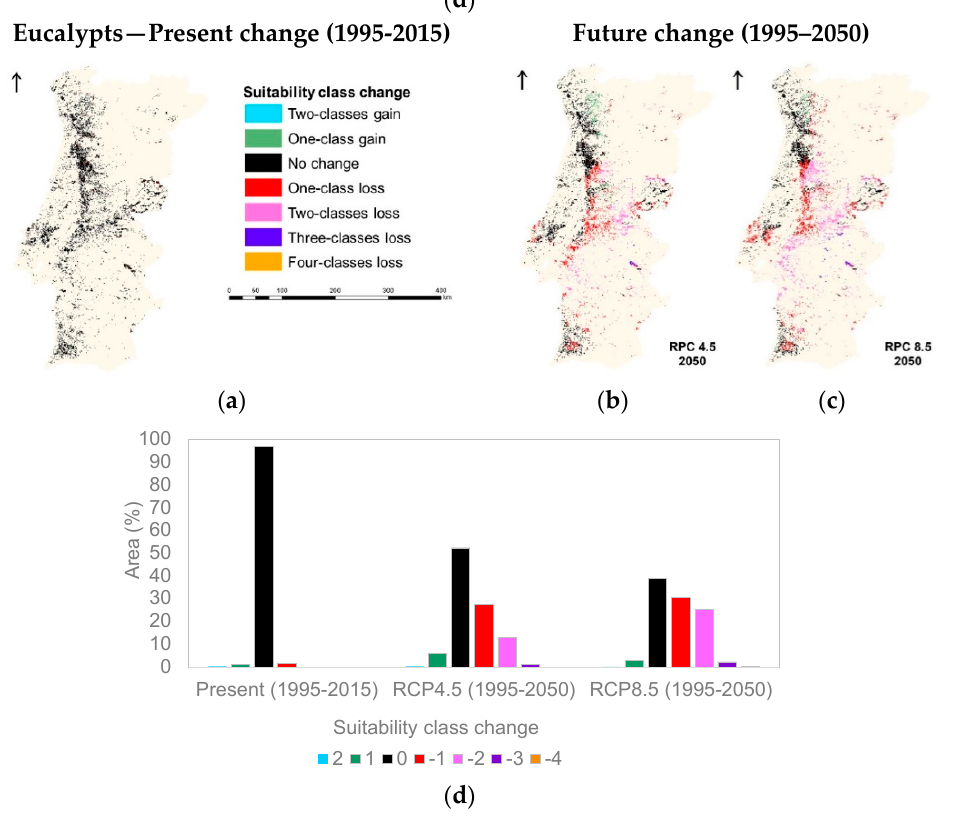
Figure 7. Species distributions—Ecological envelopes class change: ( a ) Present (1995–2015); ( b ) Future RCP4.5 scenarios (1995–2050); ( c ) Future RCP8.5 scenarios (1995–2050); ( d ) Suitability classes change percentage areas